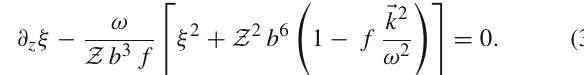
The results obtained for ˜ ρ from numerical calculations at different temperatures are shown in Fig. 5. The location of the peak corresponds to the thermal mass of the ground